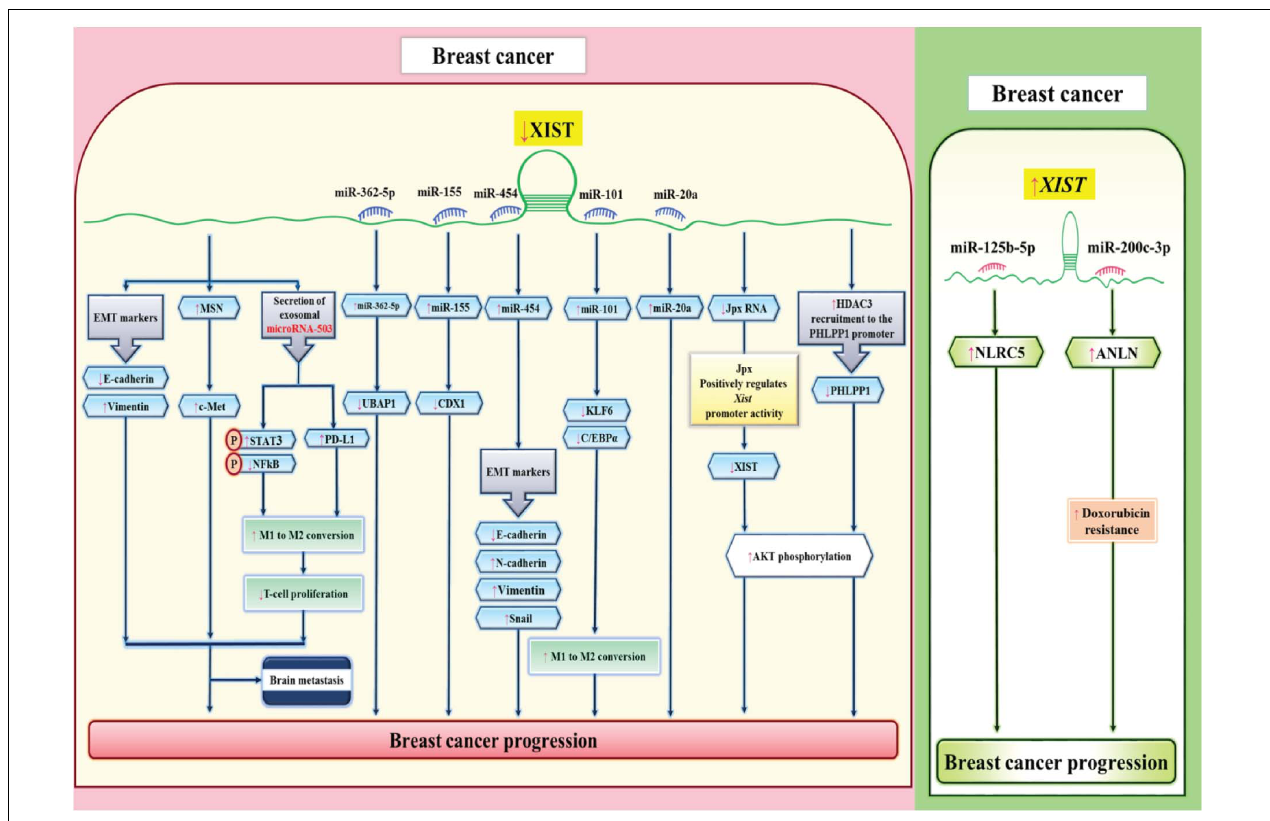
FIGURE 1 | Different studies have shown the tumor suppressor role of XIST in breast cancer through sponging miRNAs (Li et al., 2020d; Liu et al., 2020) and regulating expression of epithelial-mesenchymal transition (EMT) markers (right panel). On the other hand, other studies have reported oncogenic roles for XIST (Zong et al., 2020) (left